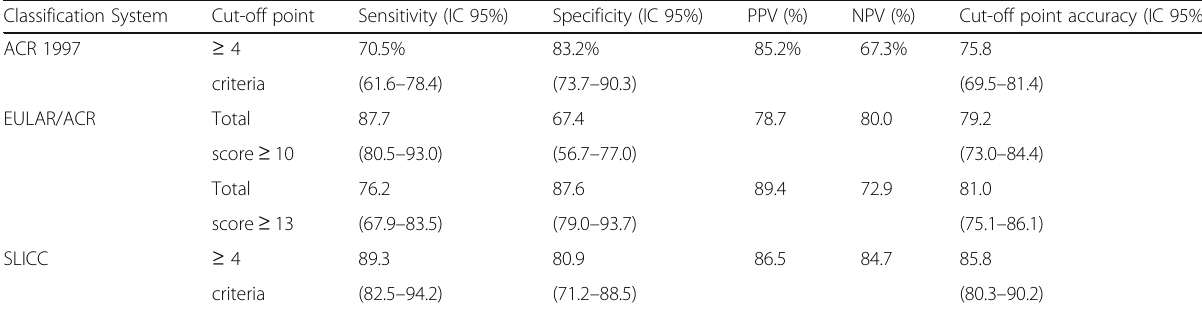
Table 4 Performance measures for ACR 1997, SLICC and new EULAR/ACR criteria, at baseline/first visit Classification System